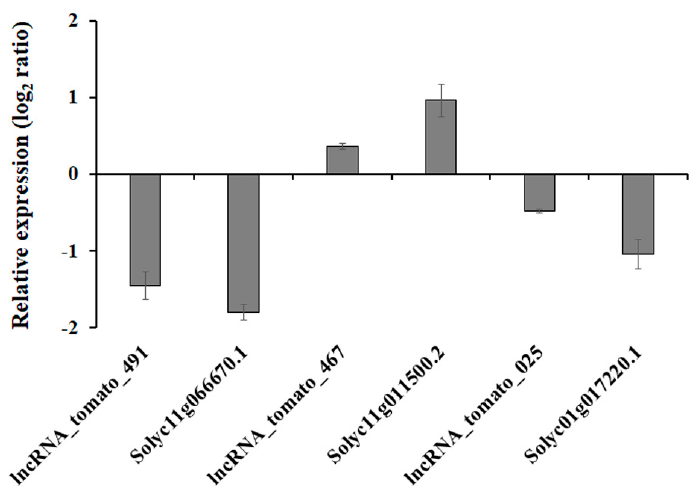
Figure 5. Transcriptional changes of selected lncRNA–mRNA pairs during the response to drought stress. Transcript levels of the selected lncRNA–mRNA pairs were normalized to those of tomato actin and were expressed relative to the values in the non-treated sample. The level of expression is represented as the log2 ratio. Data are means ± SE.